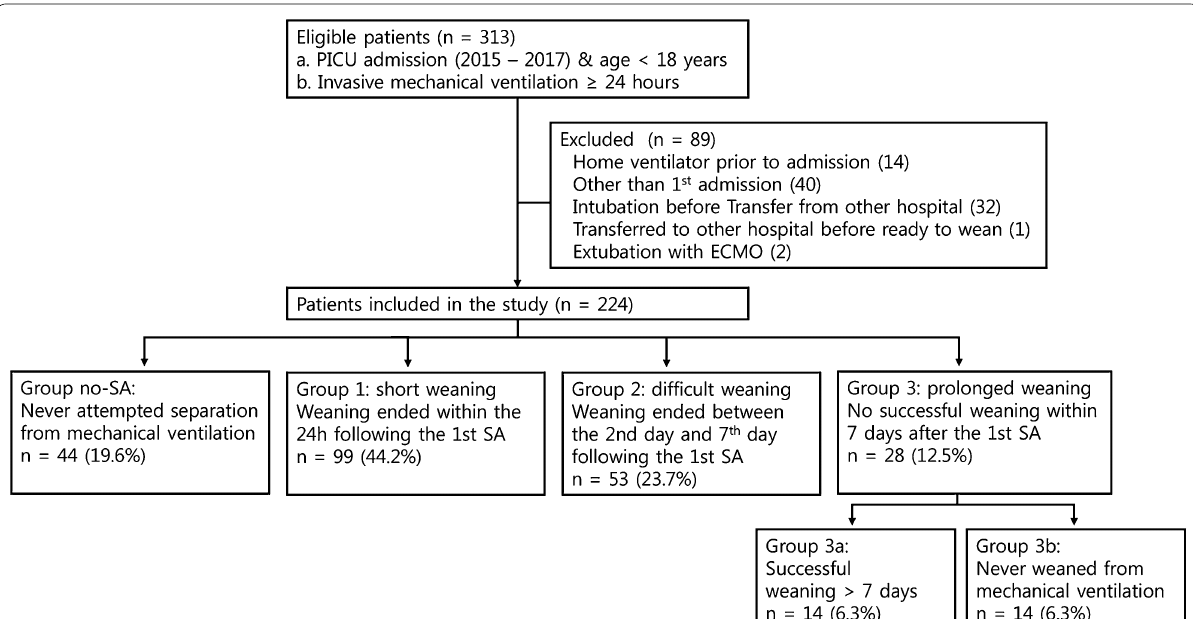
Fig. 1 Flow diagram of patient selection, with inclusion and exclusion criteria and weaning classifications. PICU pediatric intensive care unit, ECMO extracorporeal membrane oxygenation, SA separation